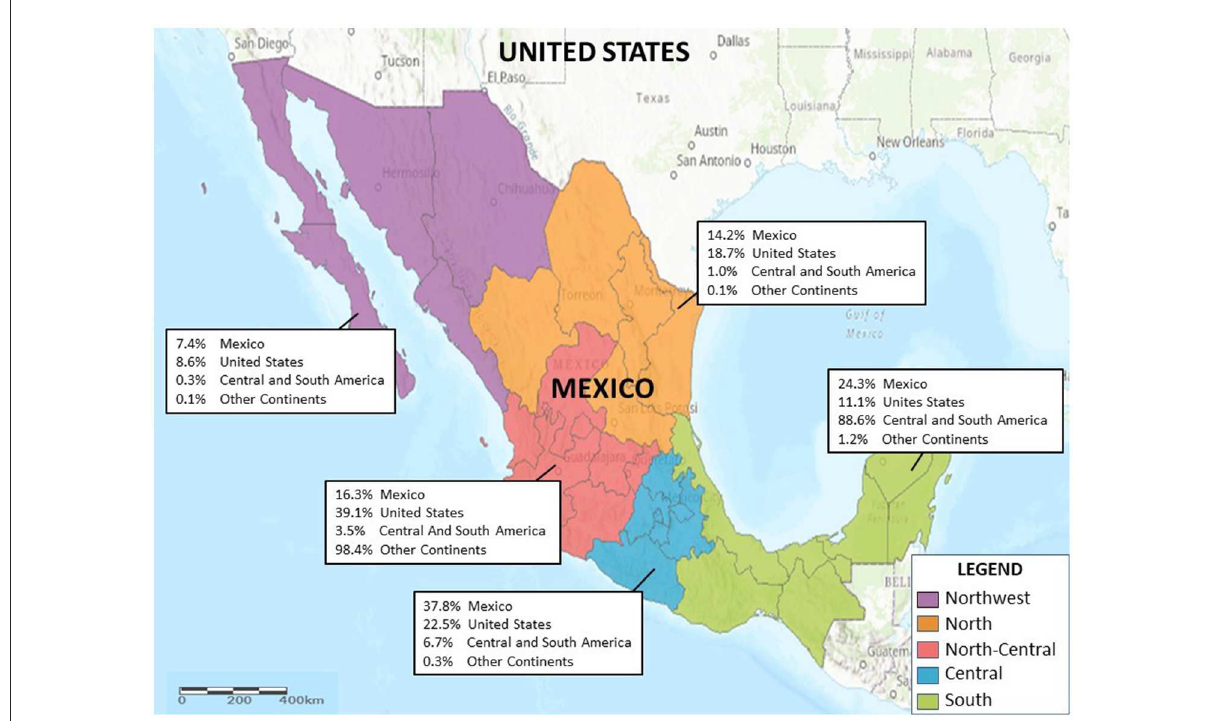
FIGURE1 Proportion of hospitalizations by geographic region and habitual residence.